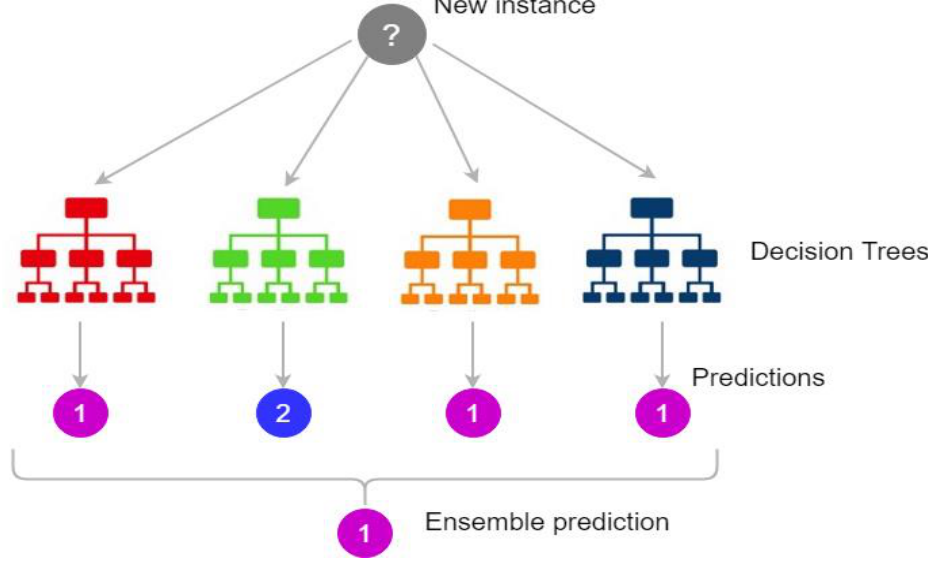
Figure 2. Random forest prediction